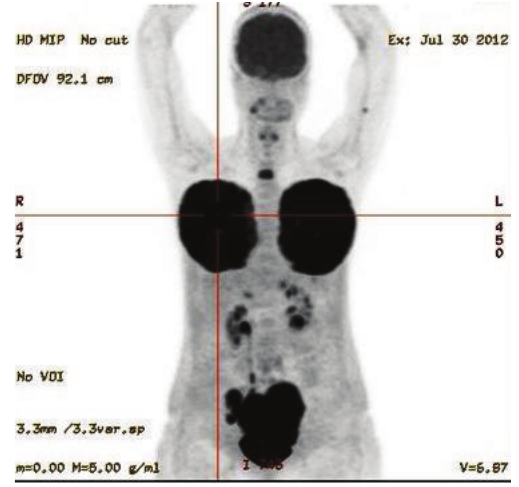
Figure 3: Initial PET scan showed massive FDG activation in bilateral breast masses and